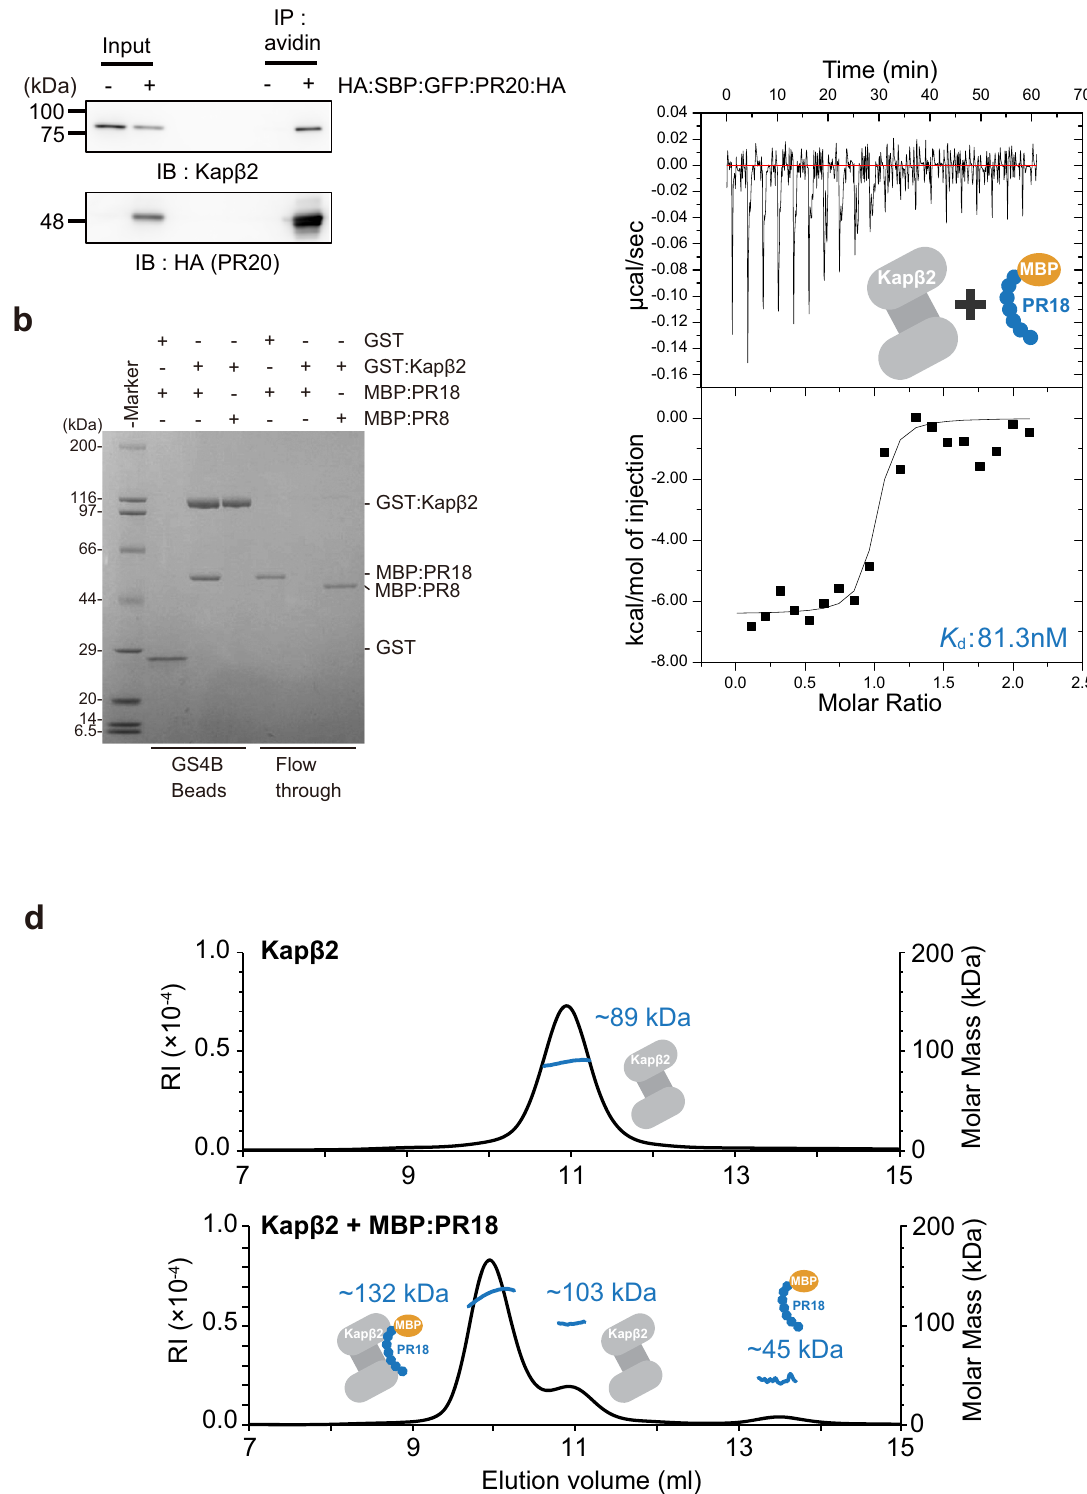
Fig. 2 Interaction between Kap β 2 and PR poly-dipeptides. a Immunoprecipitation showing interaction between endogenous Kap β 2 and HA:SBP:GFP:PR20:HA expressed in HeLa cells. b Pull-down binding assay showing interaction between GST:Kap β 2 and MBP:PR18/MBP:PR8. c Dissociation constant ( K d ) measured by ITC of Kap β 2 ( Δ Loop) binding to MBP:PR18. d SEC-MALS of Kap β 2 in the absence and presence of MBP:PR18, showing a 1 : 1 complex formation between Kap β 2 and MBP:PR18. The experiments ( a , b ) were independently repeated three times or more with similar results. Source data are provided as a Source Data fi